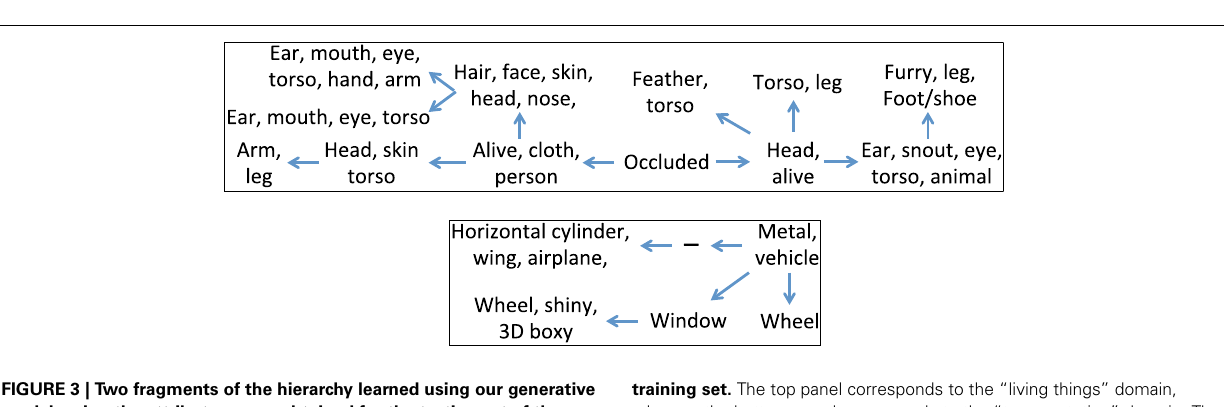
FIGURE 2 | Two fragments of the hierarchy learned using our generative model, using the annotated attributes available for the training set of the PASCAL dataset. The left panel